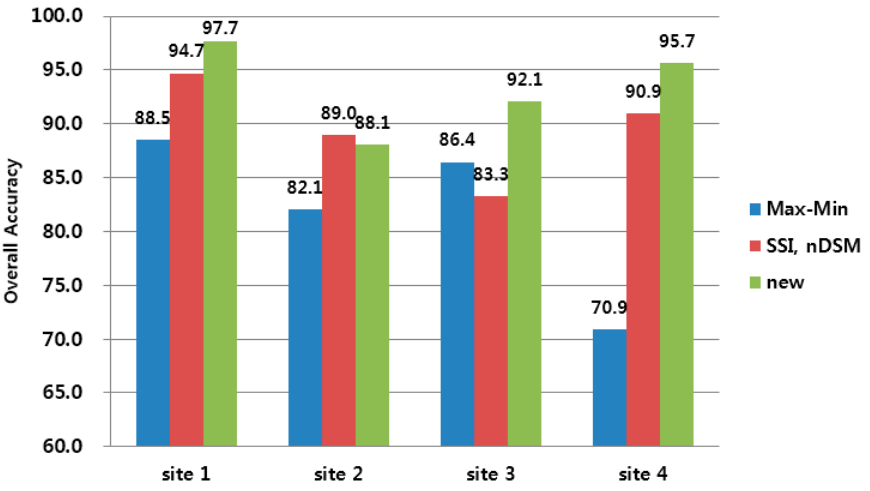
Figure 10. Overall accuracy of three classification results. Table 2. Improved accuracies of the new method over the other methods.